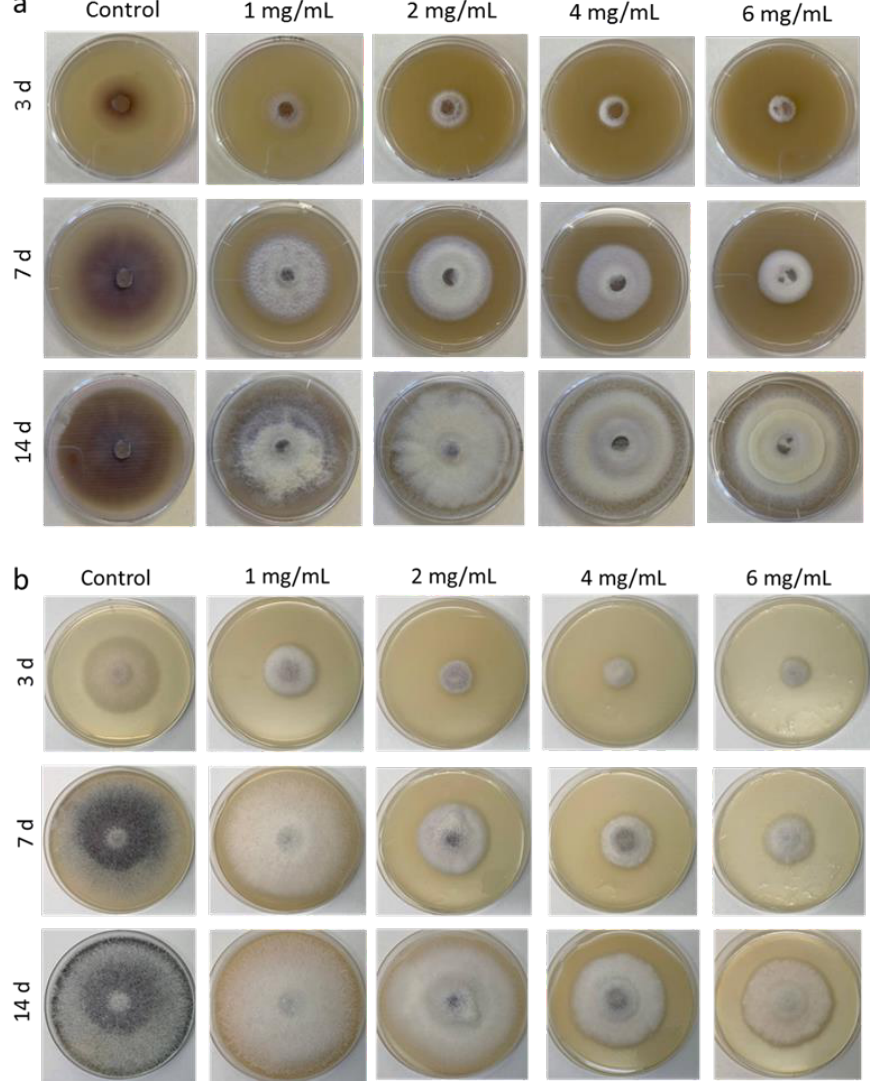
Figure 2. Growth of F. proliferatum on PDA with different concentrations of Ch1 ( a ) and Ch2 ( b ) for 3, 7, and 14 days.